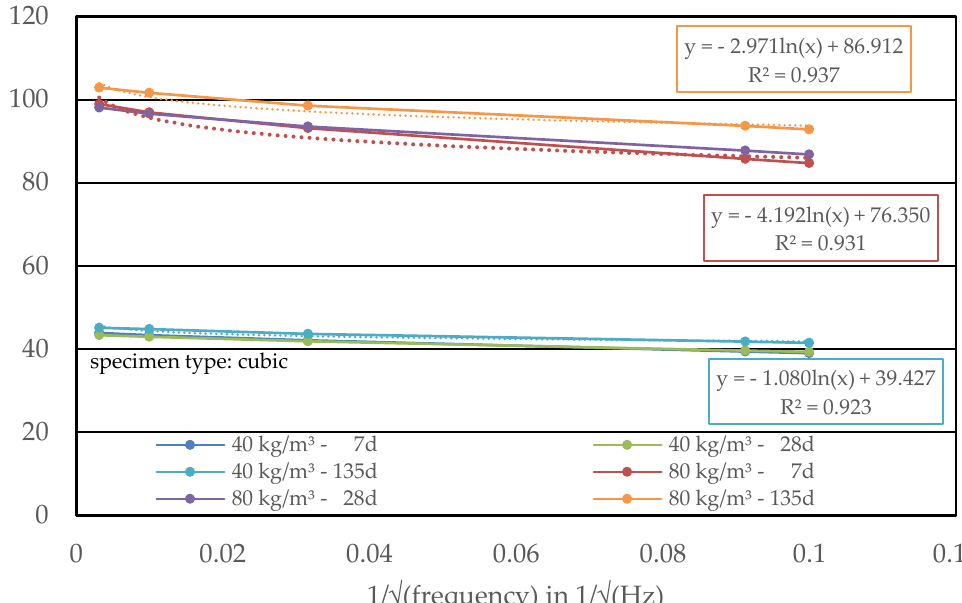
Figure 7. Calculated fibre content of the cubic specimens at varying frequencies of the alternating current of the samples with a fibre content of 80 kg/m³(dotted lines represent the fitted trend lines according to the equations given in the corresponding graph).